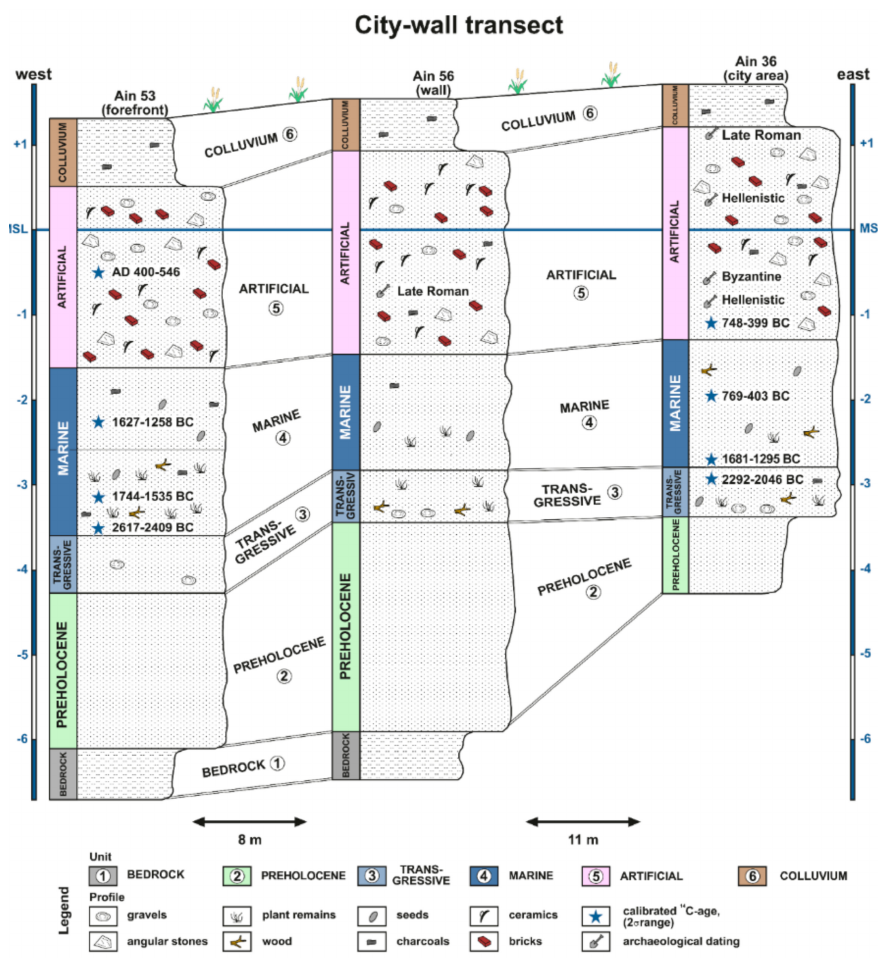
Figure 6. Synopsis of the coring transect Ain 53—56—36 situated directly on the track of the ERT profile E8 (for location see Figure 4). Table 1. Radiocarbon data sheet. 14 C-AMS dating was carried out at the 14 Chrono Centre for Climate, the Environment, and Chronology, Queen’s University Belfast, UK (lab code: UBA). All ages were calibrated with IntCal13 or MARINE13 using the Calib 7.1 software [62]. A marine reservoir effect of 390 ± 85 years and a ∆ R of 35 ± 70 years were applied [63]. The calibrated ages are presented in calendar years BC/AD and years BP (before AD 1950) with 2 σ confidence